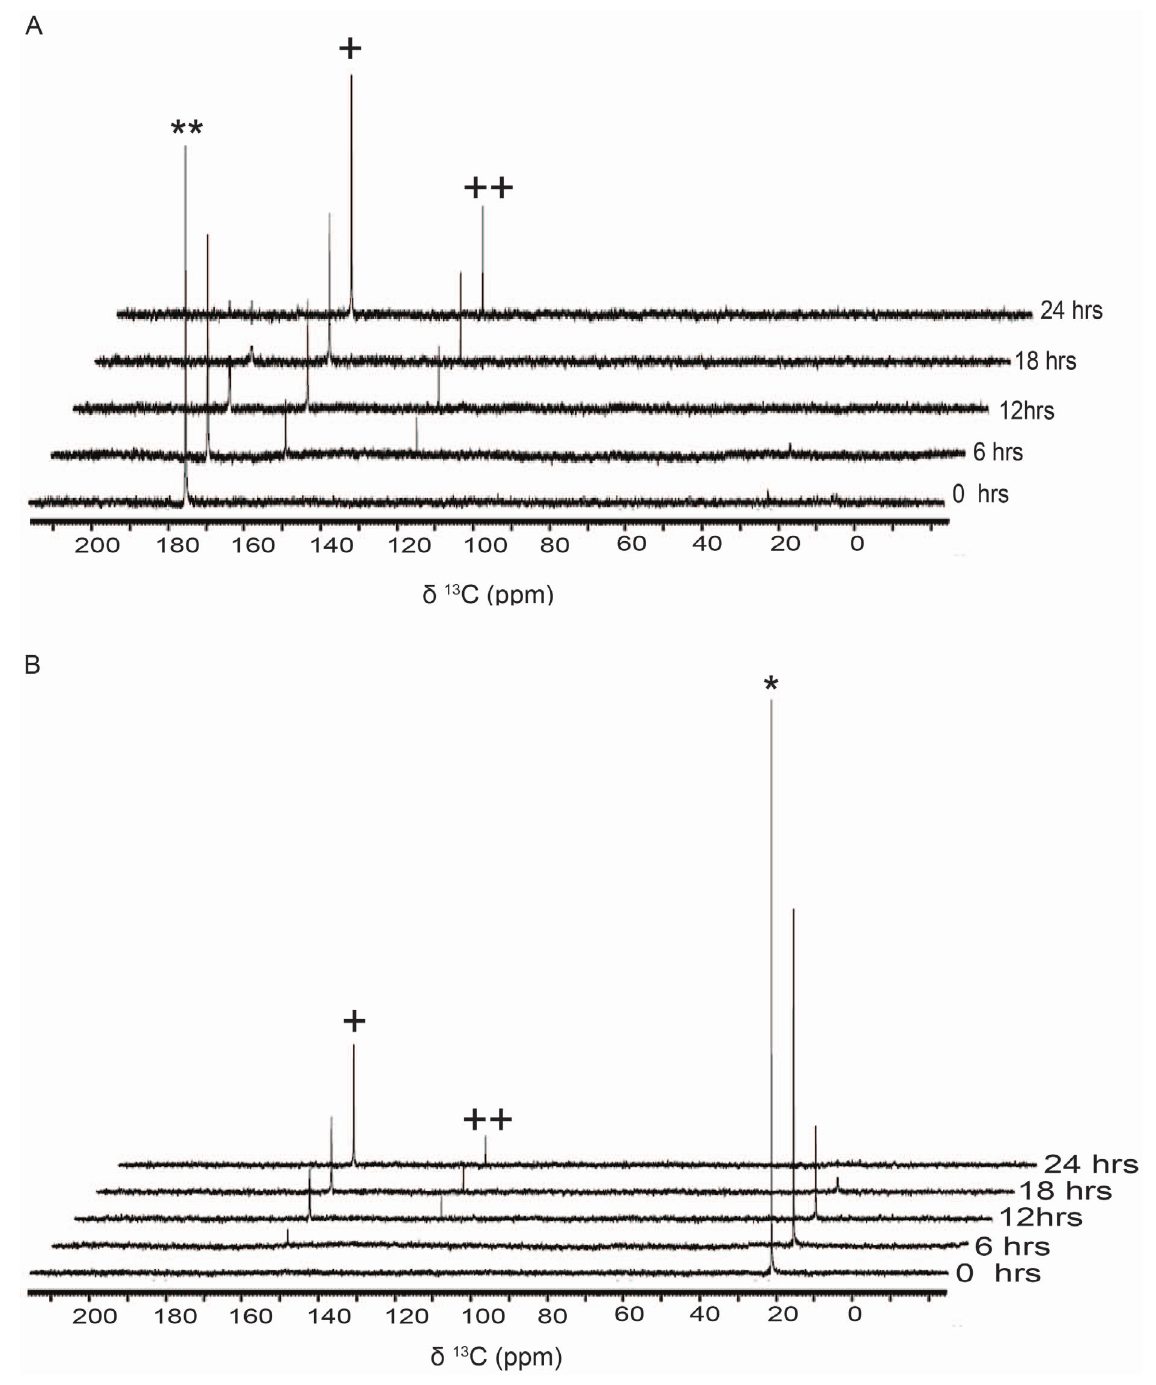
Figure 2. Assimilation kinetics of Carboxyl and Methyl [ 13 C]-carbons of acetate in heterotrophic cells. (A) Assimilation kinetics of acetate by C. reinhardtii , as studied by recording 1D [ 13 C]-NMR spectra at different time points during heterotrophy following the addition of [1- 13 C]-acetate (where carboxyl carbon is labeled) in the TP medium. (The sign ** Represents carboxyl peak of [1, 2- 13 C]-acetic acid, and the signs + and ++ represent bicarbonate and CO 2aq peaks respectively). (B) Assimilation kinetics of acetate by C. reinhardtii , as studied by recording 1D proton decoupled [ 13 C]- NMR spectra at different time points during heterotrophy following the addition of [2- 13 C]-acetate (where in the methyl carbon is labeled) in the TP medium. (The sign * represents methyl peak of [1, 2- 13 C]-acetic acid, and the signs + and ++ represent bicarbonate and CO 2aq peaks, respectively).